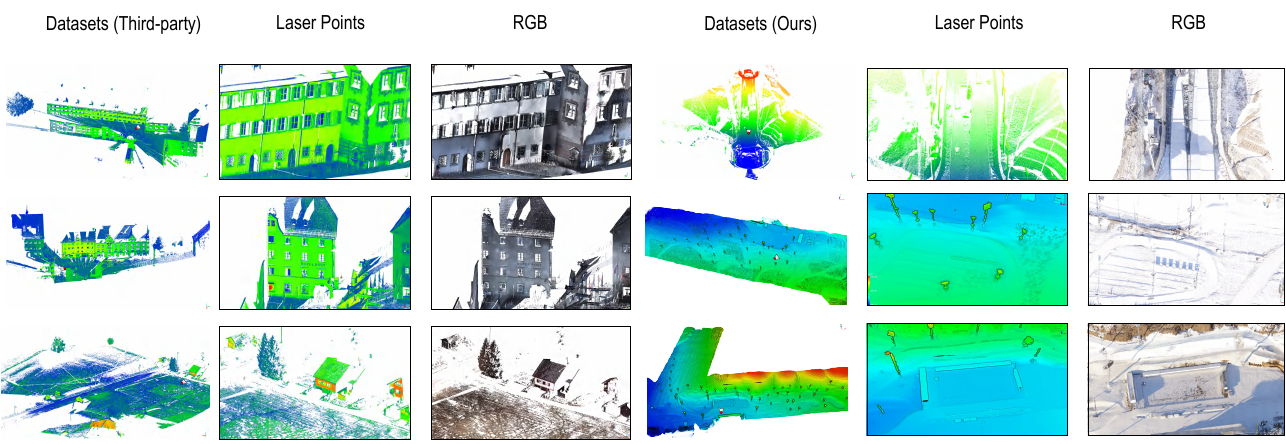
Figure 8. Experimental sample selection. In addition to showing the full picture of the six sets of data, we also selected specific small samples for testing in the form of specific perspectives ( ). Moreover, each small sample is displayed sequentially with laser point information and RGB image information. A gradient bar with a changing color based on the height is represented by .